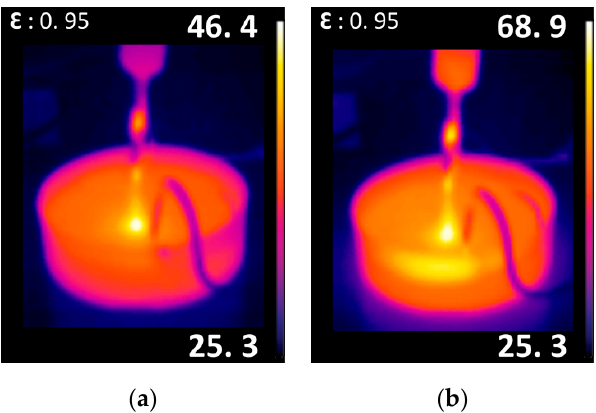
Figure 5. Thermographic image of DI water treated with AALCA for 1 min ( a ) and 5 ( b ) min.